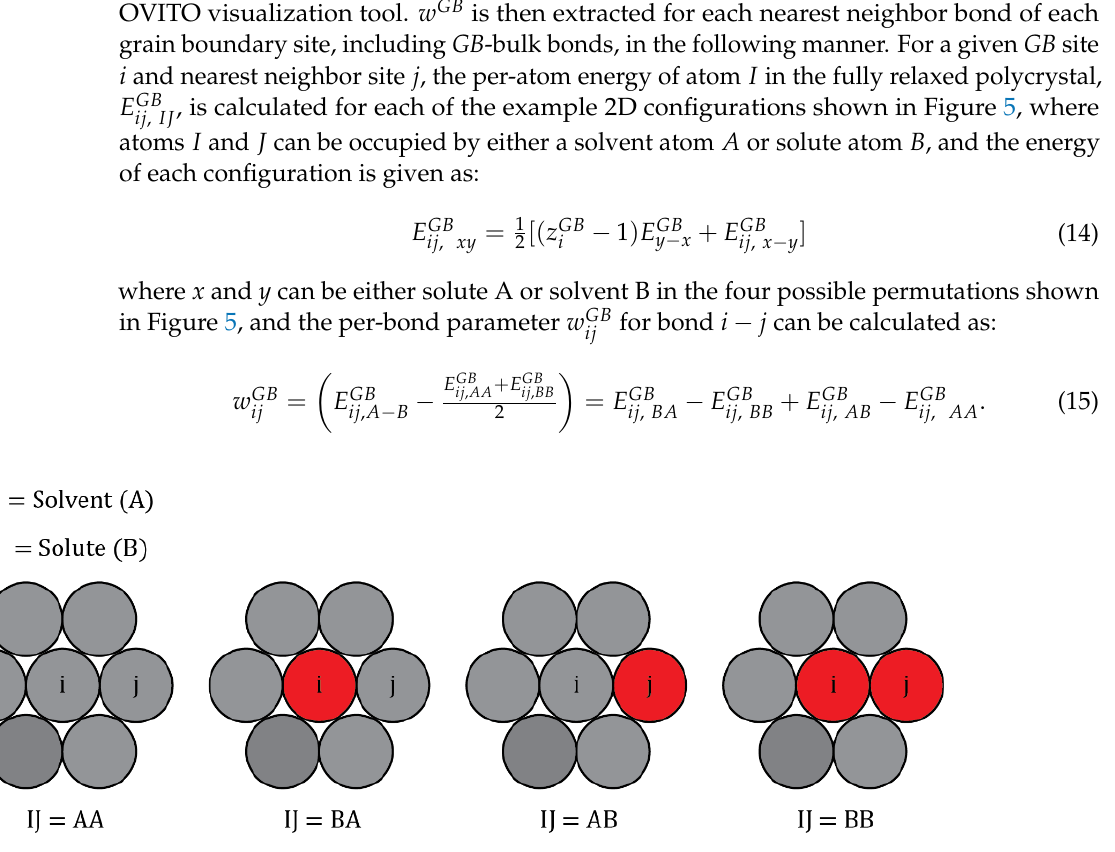
Figure 4. (a) Al-Mg polycrystal with 5% total solute, equilibrated with hybrid MC/MS at 600 K. (b) Segregation energy distribution with the equilibrium occupied distribution shown in red. Predicted occupied distribution is shown for the dilute case (Equation (9) (blue)). (c) For the (10 nm) 3 Al-Mg polycrystal: McLean-style isotherm with effective segregation energy ∆𝐸̅ 𝑒𝑓𝑓𝑠𝑒𝑔 = −26.5 (Equation (3) (green)), dilute limit spectral isotherm (Equation (9) (blue)), and polycrystal equilibrated via MC/MS, with a fitted linear interaction parameter 𝛺 𝐺𝐵 = −22.86 kJ/mol (Equation (11) (red)).